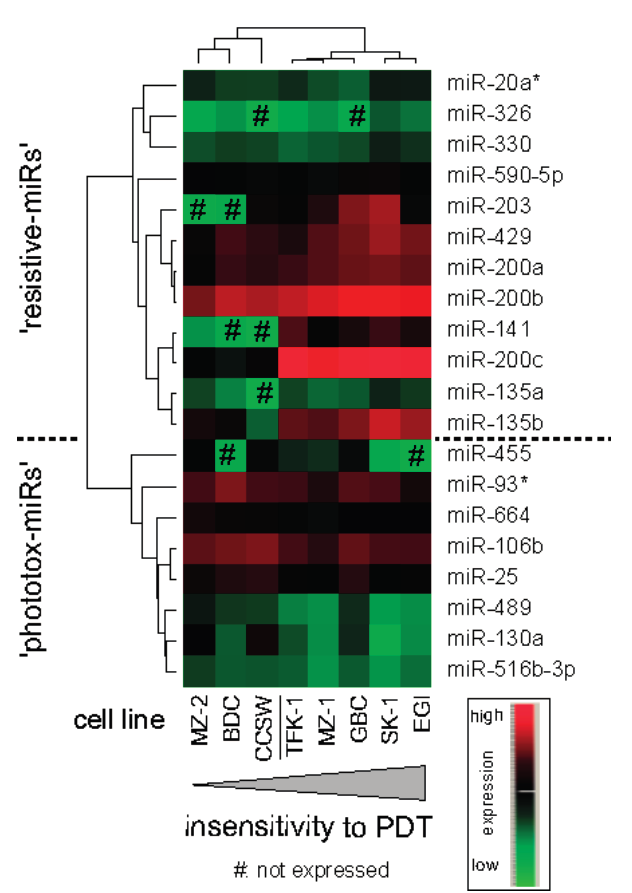
Figure 3. Expression of miRs significantly correlating with PDT. Hierarchical clustering reveals two clusters of cell lines: five differentiated/PDT-resistive and three less differentiated/PDT-sensitive cell lines. Some miRs (141, 203, 326, 455 and 135a) are not expressed in PDT-sensitive (clustered) cell lines (CCSW, MZ-2 and